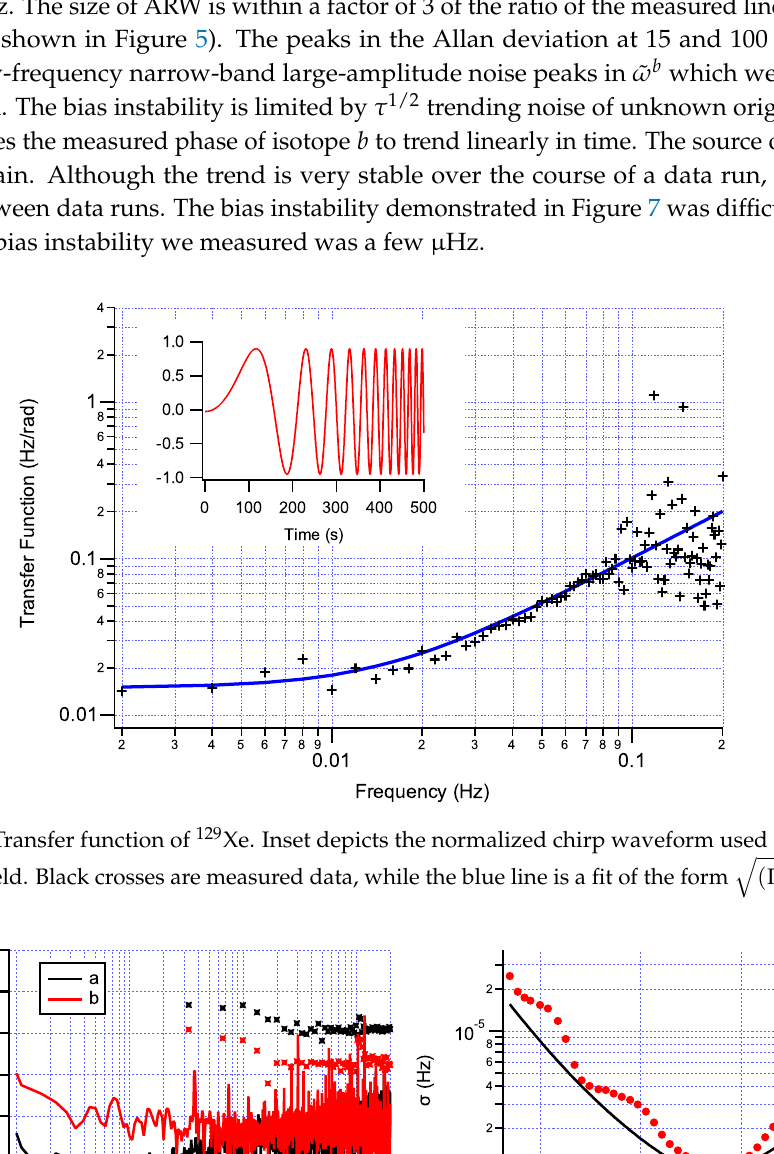
Figure 7. Measured comagnetometry noise and stability. Left: the amplitude spectral density of frequency noise. The cross marks indicate open loop frequency noise. The solid lines are frequency noise when the measured phase noise of isotope a is used to stabilize bias field. Right: modified Allan deviation of ω b . Filled circles are measured data. Solid line shows the quadrature sum of 7 × 10 − 5 τ − 1 , √ √ 15 µ Hz/ Hz τ − 1/2 , and 30 nHz Hz τ 1/2